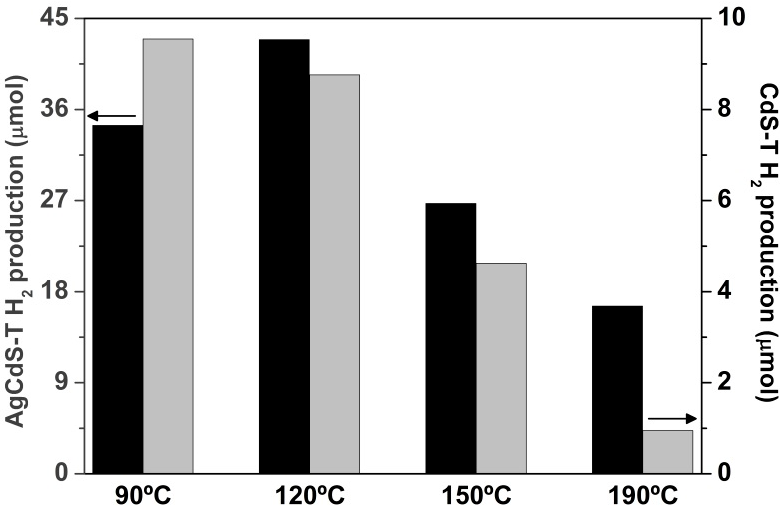
Figure 7. Hydrogen production (µmol) for AgCdS-T photocatalysts ( black ) and bare CdS-T counterparts ( grey ).